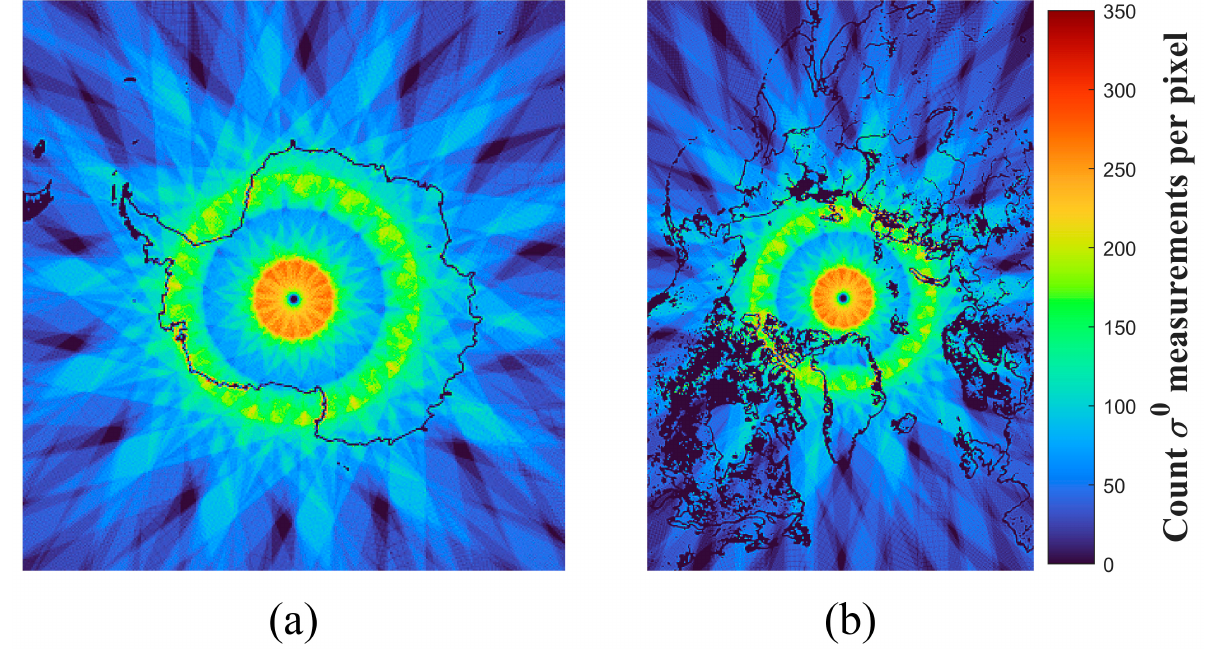
Figure 1. A number of ASCAT measurements in ( a ) Antarctic and ( b ) Arctic areas on 4 January 2020. The coastlines are overlaid in black, while the color bar represents the count of measurements in each pixel. The image sizes of the Arctic and Antarctic ice maps are 448 × 304 and 332 × 316, respectively.